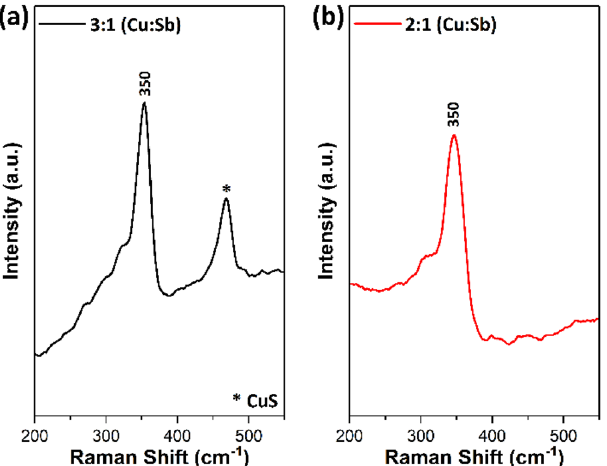
Figure 5. Raman spectra of tetrahedrite Cu 12 Sb 4 S 13 samples obtained at ( a ) 3:1 and ( b ) 2:1 molar ratio of Cu and Sb xanthate precursors.